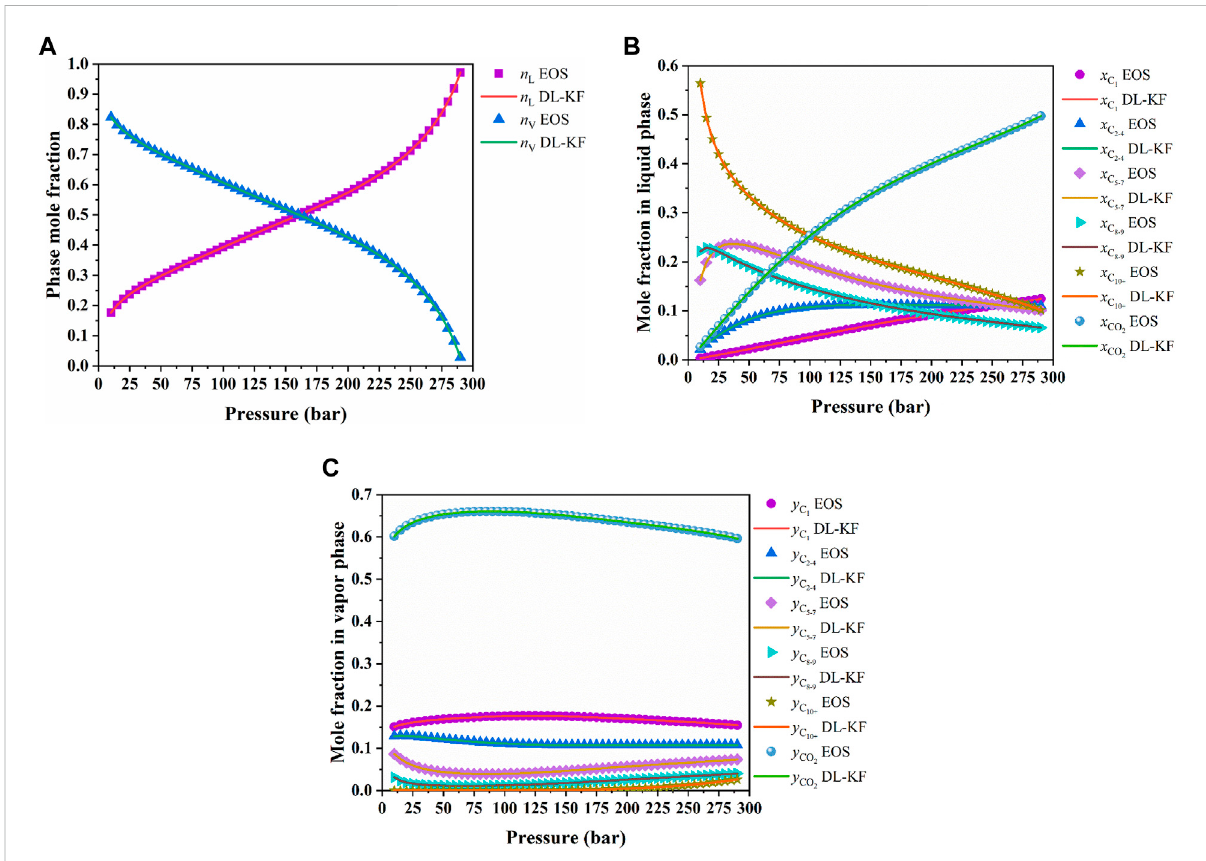
FIGURE 12 Calculation results of the mole fraction compared between the DL-KF modeling and original EOS modeling. (A) The liquid and vapor phase mole fraction. (B) The mole fraction of components in liquid phase. (C) The mole fraction of components in vapor phase.